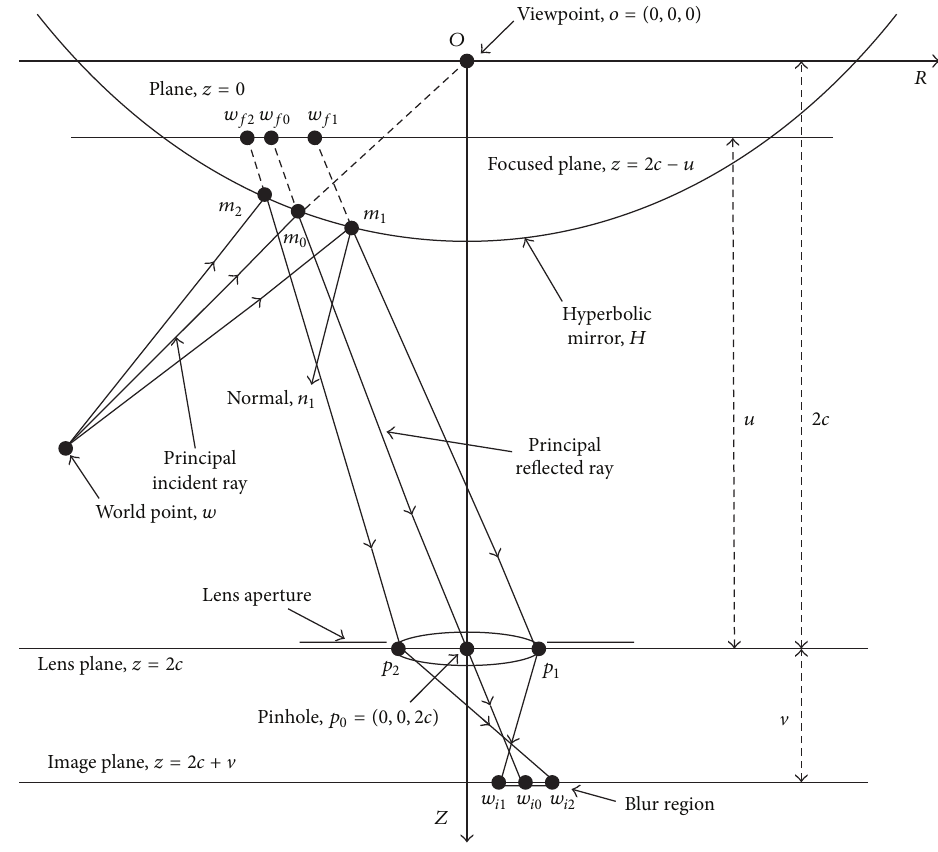
Figure 1: Defocus sketch map of a catadioptric omnidirectional imaging